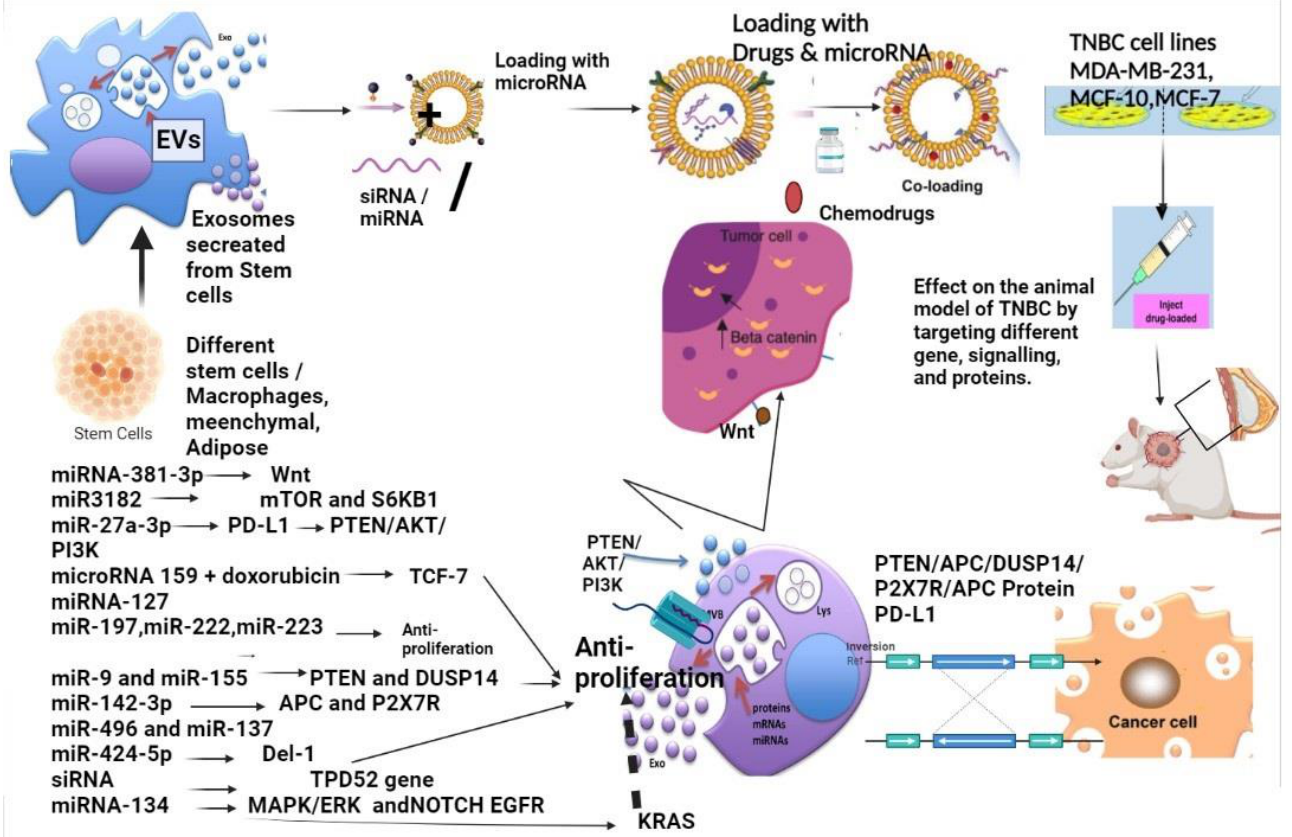
Figure 4. Exosomes generated from adipose mesenchymal stem cells infused with miRNA-381-3p downregulate the expression of Wnt signalling and inhibit EMT. miR3182 conjugated with exosomes derived from the human umbilical cord induce apoptosis in the TNBC cell line through downregulating genes such as mTOR and S6KB1. Exosomal miR-27a-3p, through production by endoplasmic reticulum stress, enhances immunological escape in breast cancer through modulating PD-L1 levels in macrophage’s immune evasion via the PTEN/AKT/PI3K axis. microRNA 159 and doxorubicin cause a synergetic effect on the TCF-7 gene and improve the anticancer effects. Exosomes containing miRNA-127, miR-197, miR-222, and miR-223 from stroma also aid breast cancer cell quiescence and enhance anti-proliferation rates. miR-134 targets the pathways such as MAPK/ERK and other signallings such as EGFR and NOTCH. Upward expression of miR-134 also represses breast cancer metastasis by targeting KRAS. miR-9 and miR-155 target PTEN and DUSP14 tumour suppressor genes in MCF-7 cell lines extracted from MDA-MB-231 exosomes. miR-496 and miR-137 loaded in exosomes from the MCF10A cell line target Del-1 and modulate it by inhibiting tumour growth in the TNBC cell lines such as MCF10A and MDA-MB-231. Extracellular vesicles derived from adipose mesenchymal cells enhance apoptosis by suppressing PD-L1 signalling in MDA-MB-231 TNBC cells.